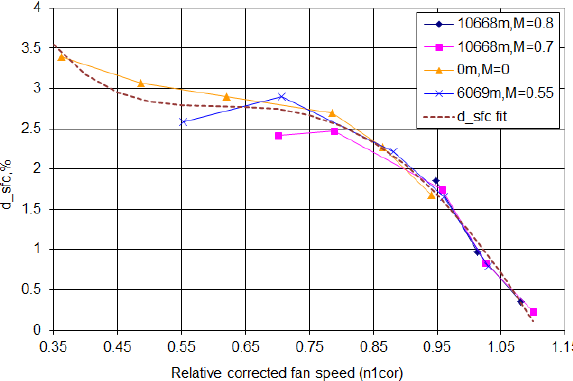
Figure 1. The relative increase of the specific fuel consumption of the deteriorated engine (d_sfc) as a function of the relative change of the fan speed (d_ n 1 )